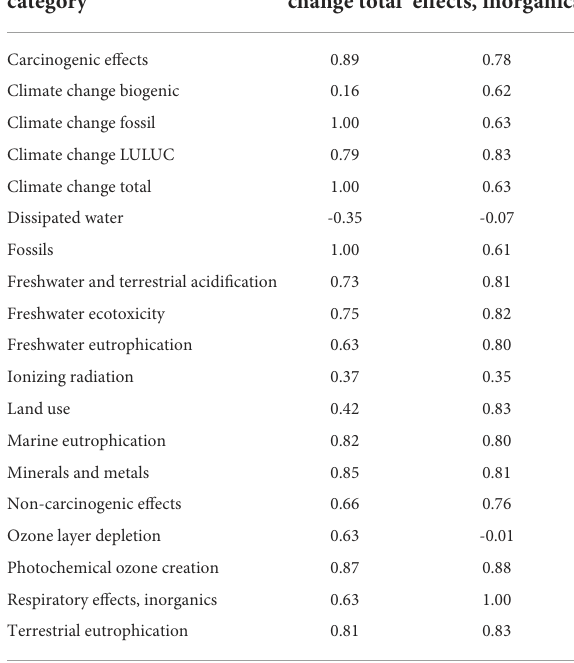
TABLE 2 Summary of the analyzed correlations between the Climate change total impact and Respiratory effects, inorganics indicators, and the remaining 18 impact indicators for the hourly impacts of electricity consumption throughout the full dataset, computed with the Pearson